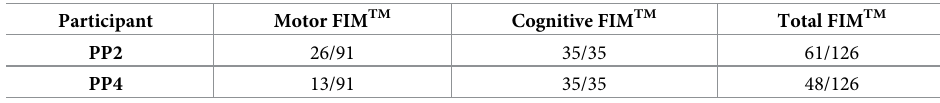
Table 9. FIM TM results of the participants who did not use the